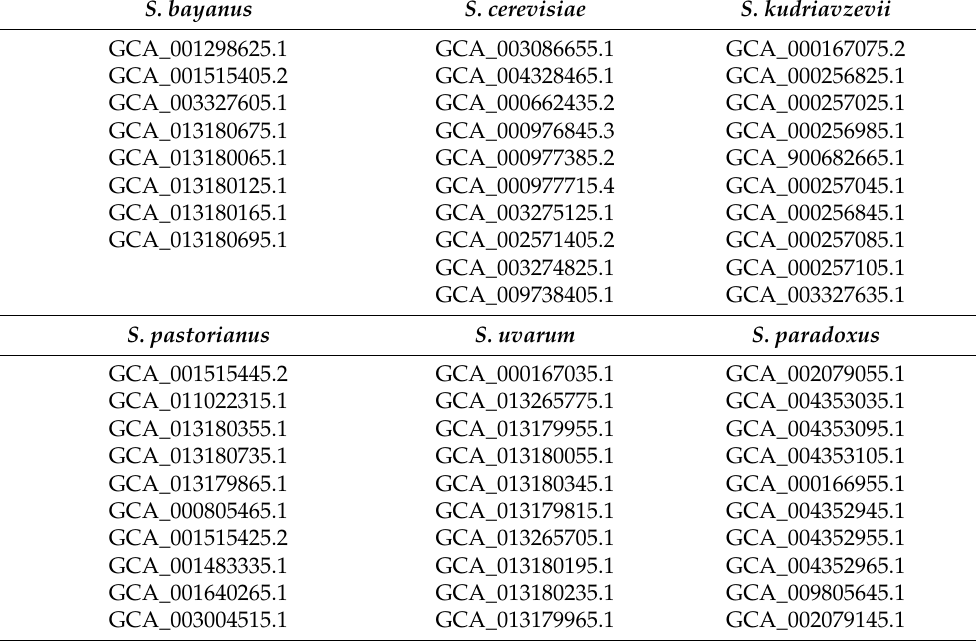
Table 1. List of Saccharomyces and Candida genomes used for the